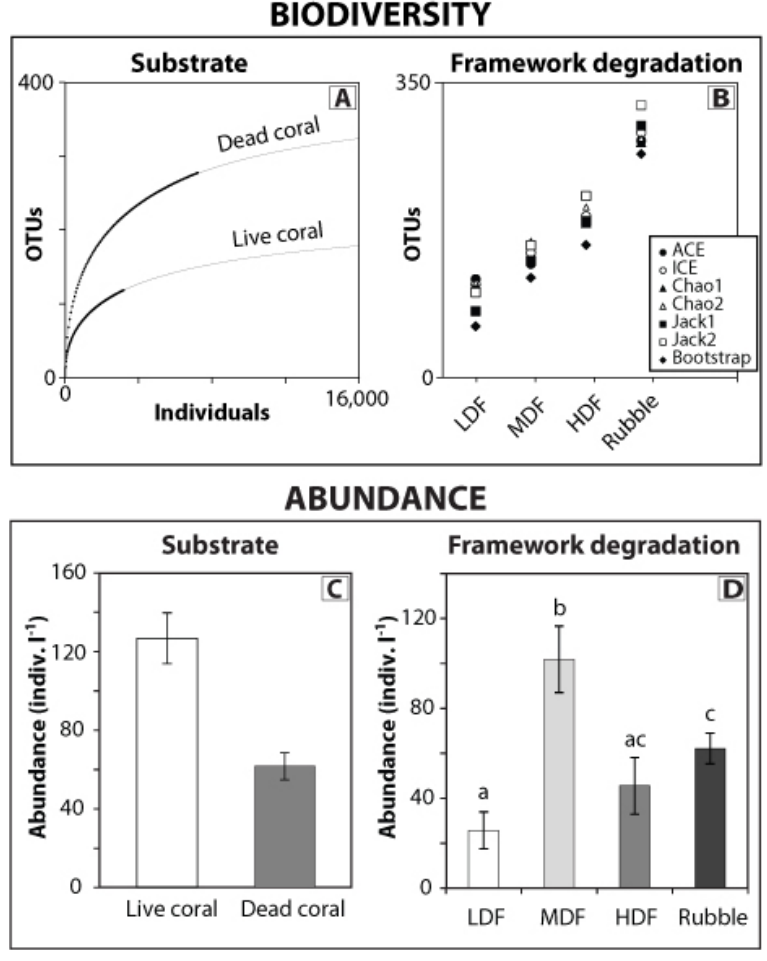
coral substrates ( A ) and nonparametric richness estimators of cryptofaunal communities associated with dead frameworks in four zones of increasing degradation ( B ) [24]. In B, symbols correspond to the particular estimator employed. Abundances of individuals associated with live and dead coral substrates, per volume substrate ( C ) and with differing framework materials ( D ), Low Degradation Framework (LDF), roughly 80% or greater coral cover, intact three-dimensional frameworks with greatest vertical relief; Medium Degradation Framework (MDF), 20–80% coral cover, semi-eroded large framework pieces; High Degradation Framework (HDF), <20% coral cover, highly eroded and loose framework with little three-dimensional relief) [25]. In D, bars that share a common letter are not significantly